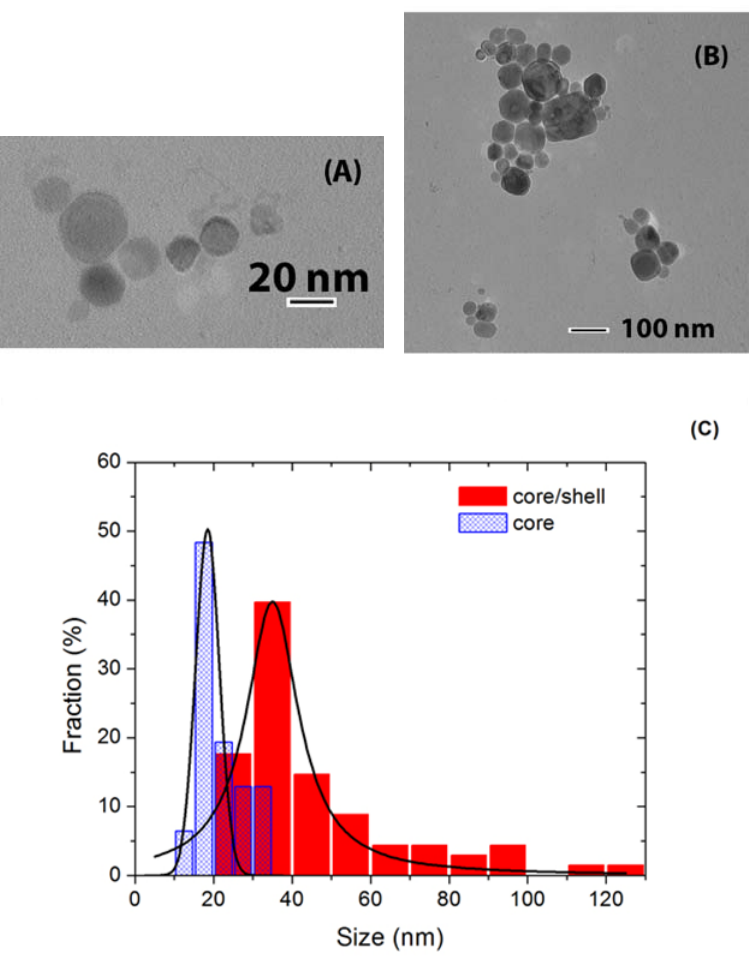
Figure 4. TEM images of (A) core and (B) core/shell BaF corresponding nanoparticle size